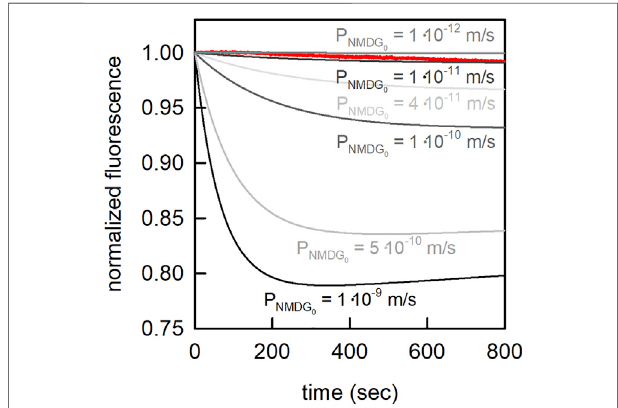
FIGURE 10 | Estimation of the passive membrane permeability of NMDG 0 . In the presence of an outwardly directed NMDG gradient (10 mM inside to 3.33 mM outside) NMDG 0 diffused out of the vesicle, which led to a drop of the intraluminal pH. The extra- and intraluminal solutions contained 1 mM MES, and 100 mM NaCl. The pH on both sides of the membrane was 7.0. Shown in red is the measured change in carboxy fl uorescein fl uorescence on imposition of the NMDG gradient at time point zero. From these measurements we estimated an upper limit for the membrane permeability of NMDG 0 ~ 10 − 11 m / s